Question: Looking at the figure, what chart type is it?
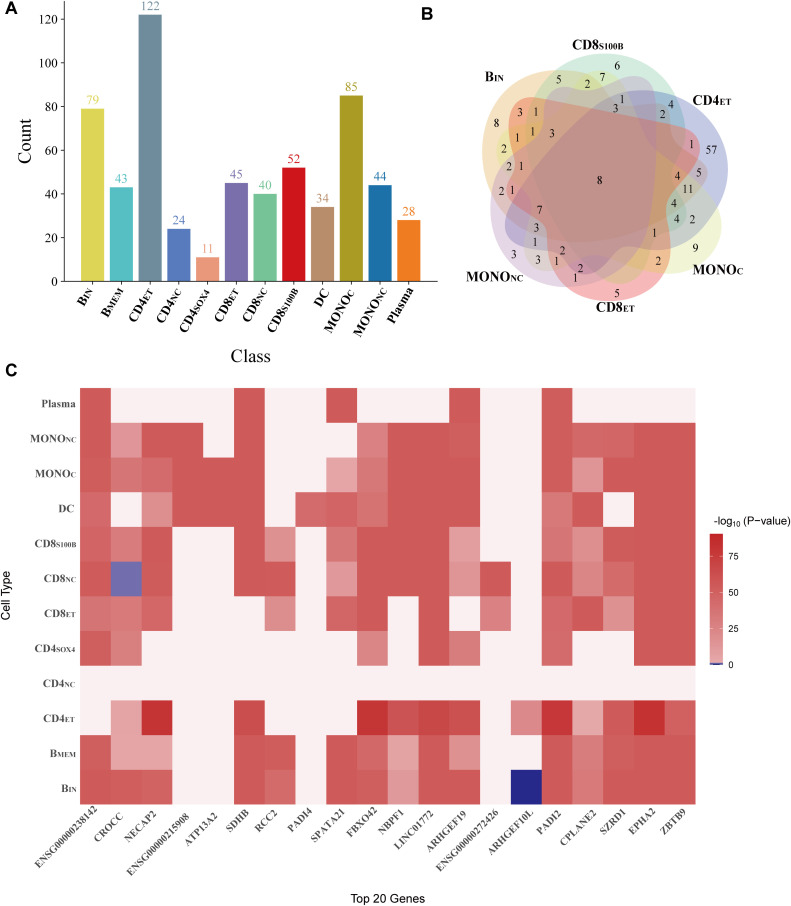
Answer: heatmap